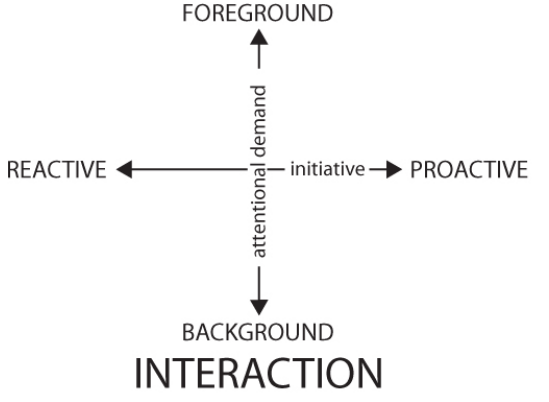
Interaction classification along the axis of attentional demand and initiative according to Ju and Leifer